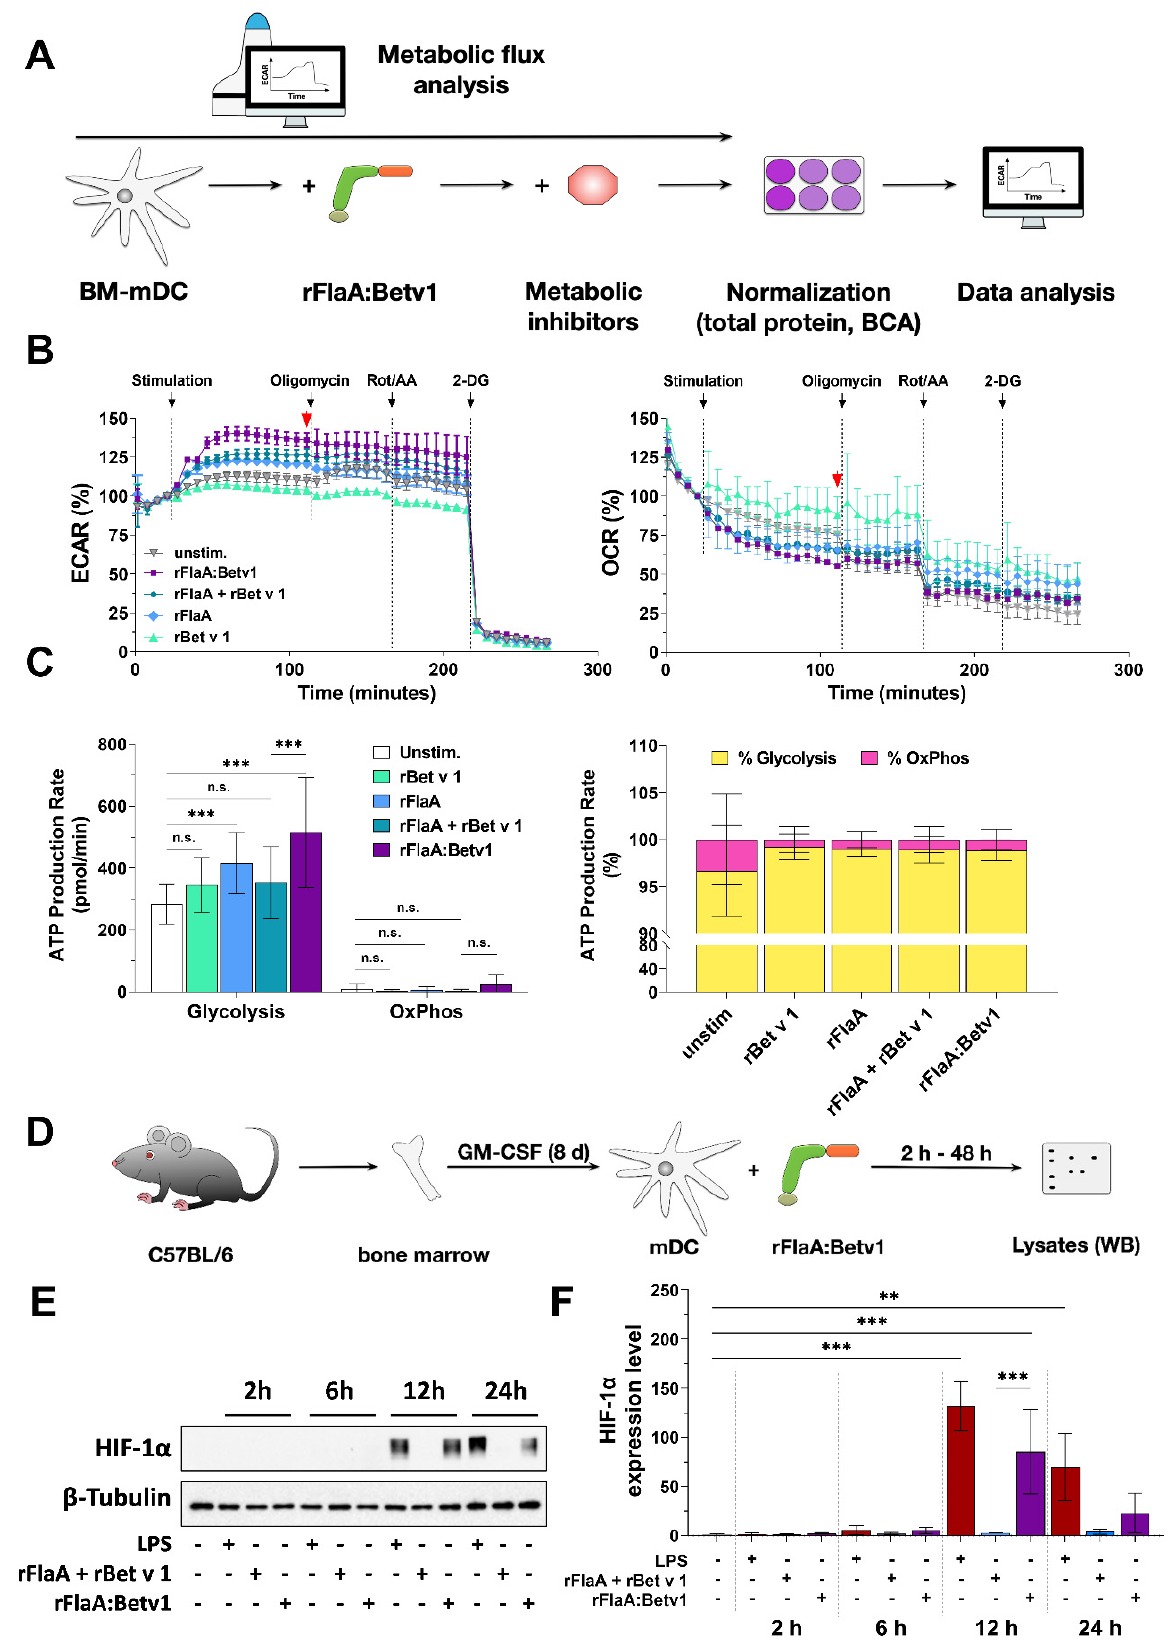
Figure 1. rFlaA:Betv1 induces a pronounced switch towards glycolysis in stimulated mDCs. C57Bl/6J mDCs were stimulated with equimolar concentrations of either rFlaA + rBet v 1 or rFlaA:Betv1 (equimolar to 4 µg/mL of rBet v 1) or 100 ng/mL LPS as a positive control and analyzed for extracellular acidification rates (ECAR) and oxygen consumption rates (OCR) using Seahorse technology ( A ). 14 cycles (84 min) post-stimulation, ATP synthase, the electron transport chain, and glycolysis were inhibited by sequential injection of oligomycin, rotenone/antimycin A (Rot/AA),